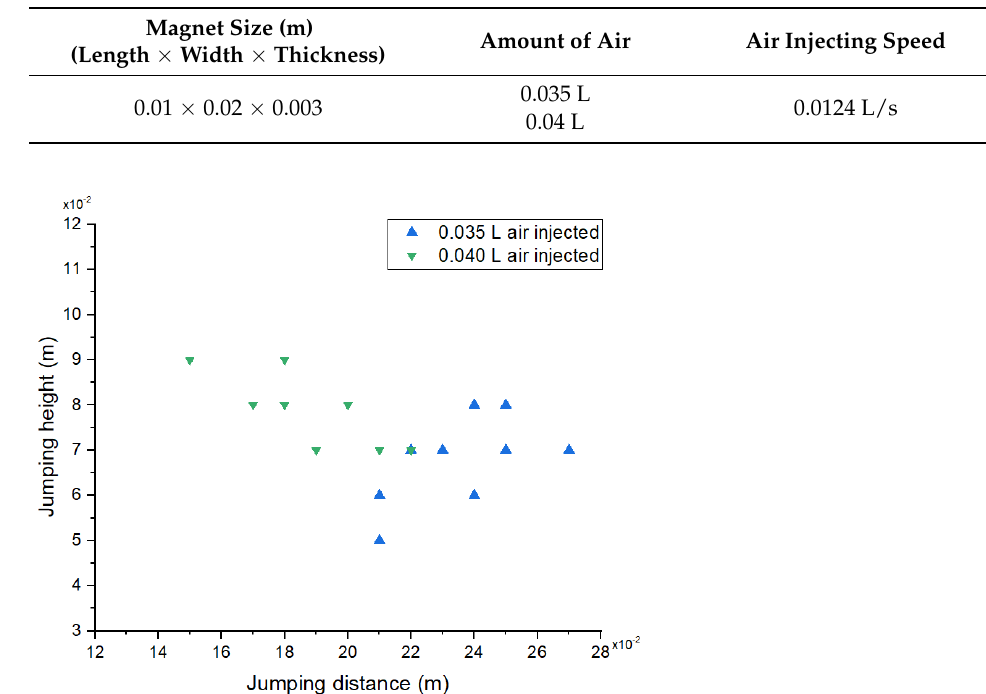
Table 6. Conditions for the robot used in the comparison of jump forces depending on the air inject- ing speed.